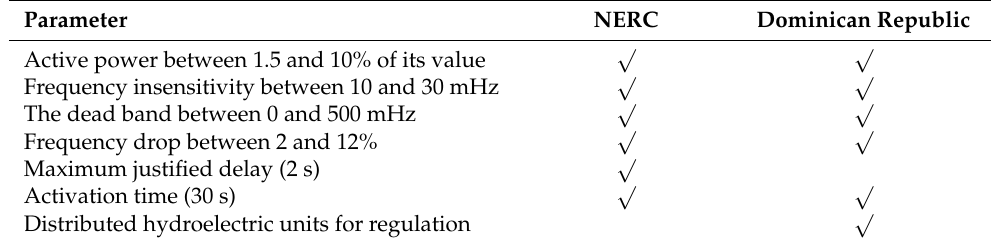
Table 5. Comparison of regulations on frequency stability.